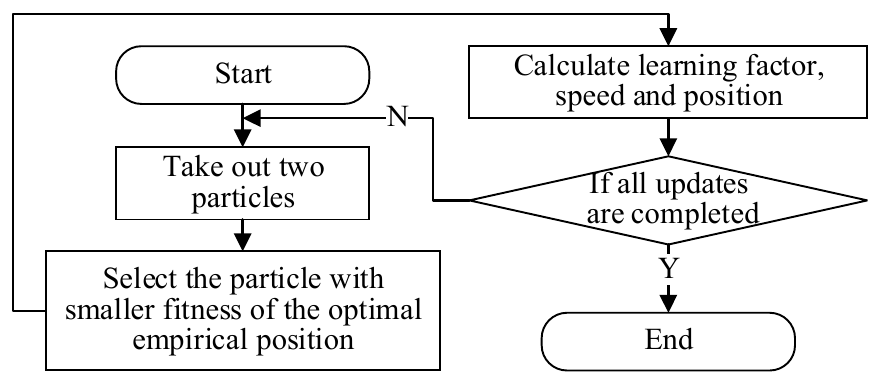
Figure 6. Flow chart of improved speed updating strategy in iterative inversion process.